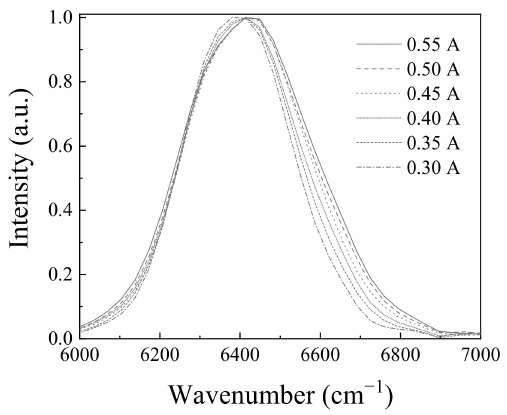
Figure 6. Spectral change of the light emitting diode according to the applied current at room tem-